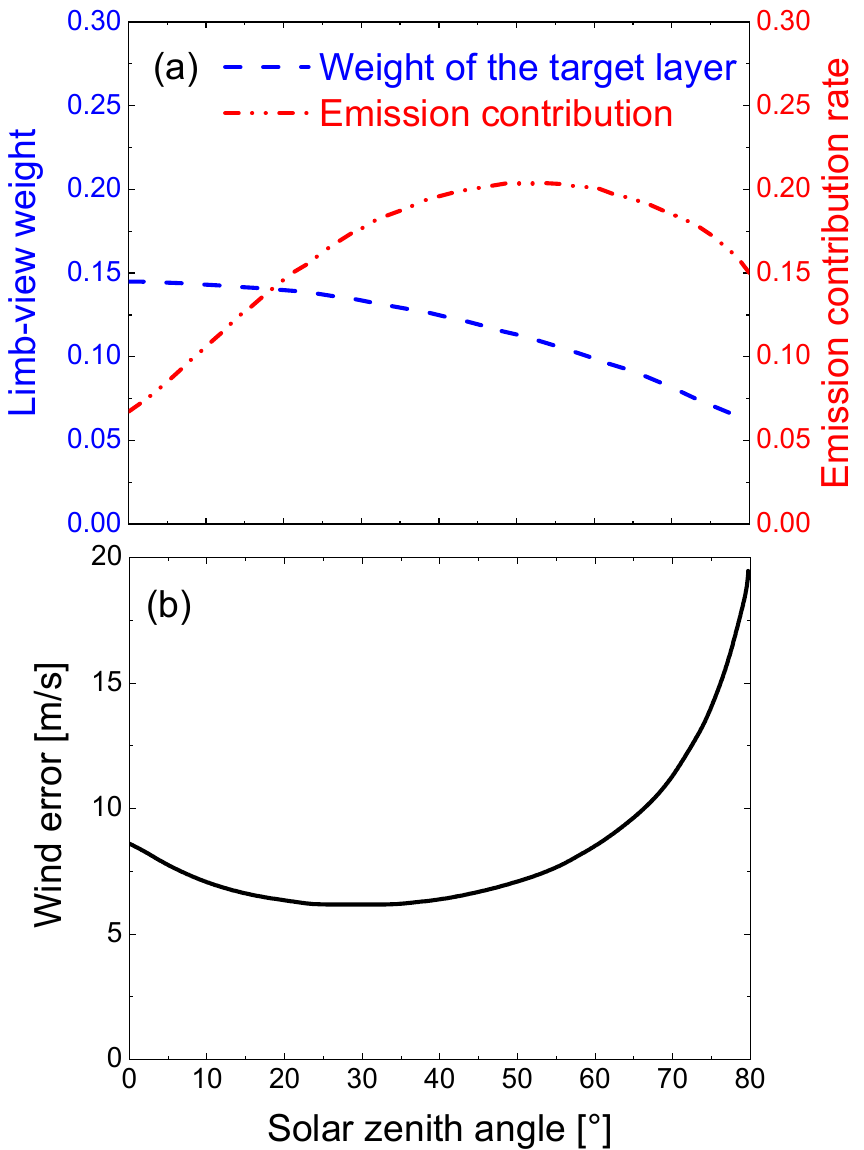
Figure 16. ( a ) The limb-viewing weight, as well as the emission contribution rate as a function of the SZA for a tangent height at 40 km; ( b ) the wind error at different values of the SZA.